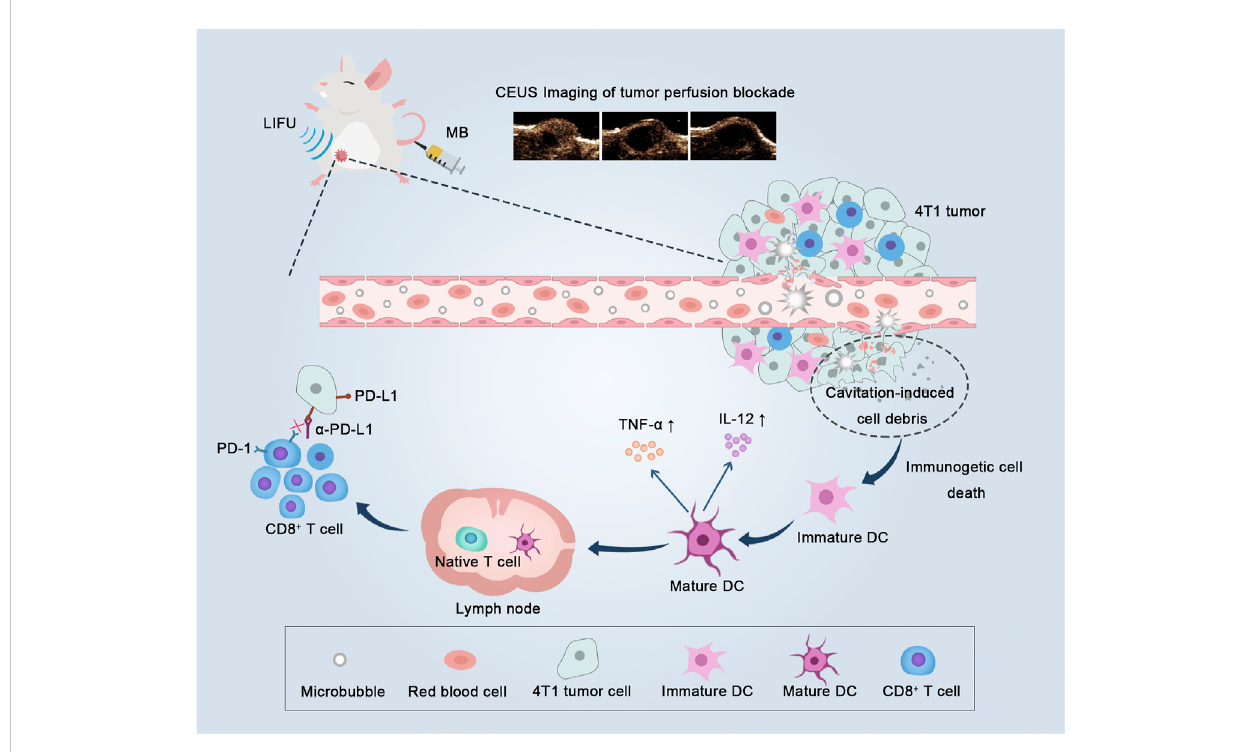
FIGURE 1 Low-intensity focused ultrasound-targeted microbubble destruction (LIFU-TMD) damages tumor vascular endothelial cells and starves tumor cells by cutting off the blood supply, and simultaneously tumor cell debris induced by the cavitation effect further stimulates dendritic cells (DCs) maturation, and ultimately activating CD8 + T cells, thereby enhancing the ef fi cacy of PD-L1